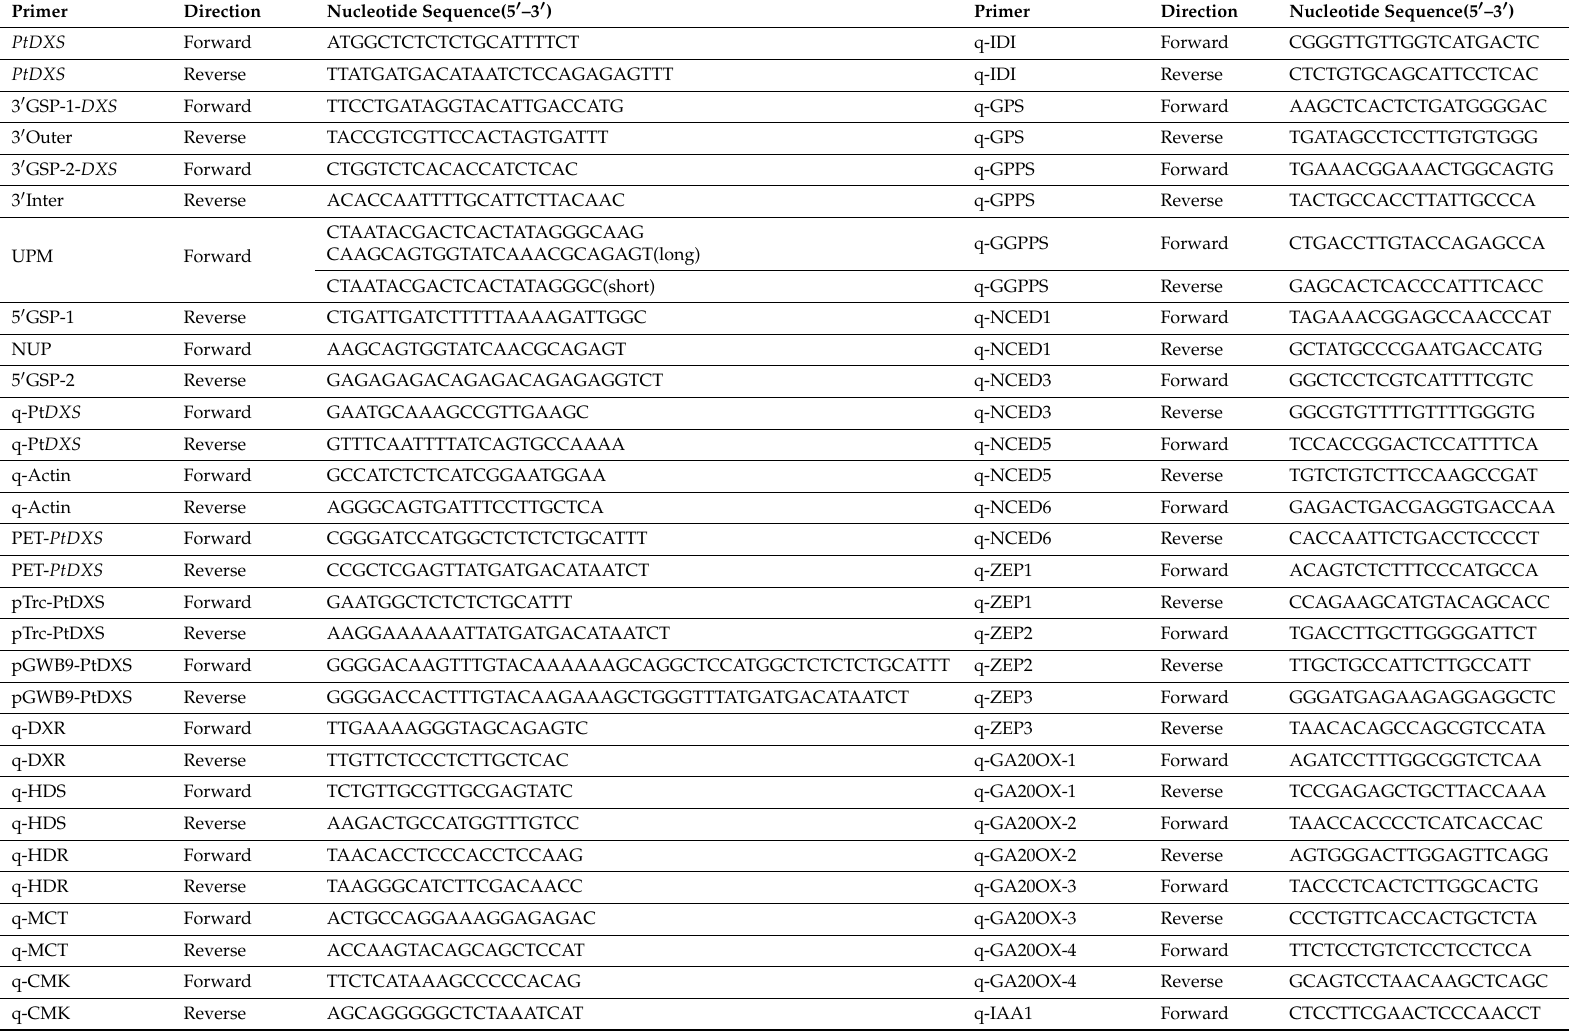
Table 1. The primers used in this